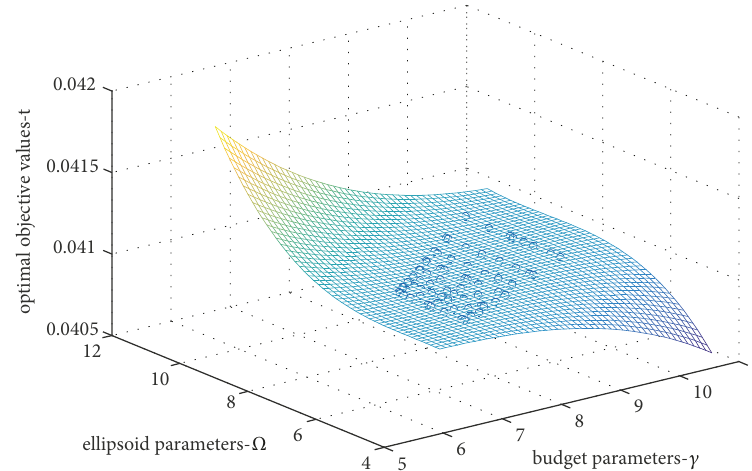
Figure 7: The optimal values under ellipsoid and generalized budget perturbation